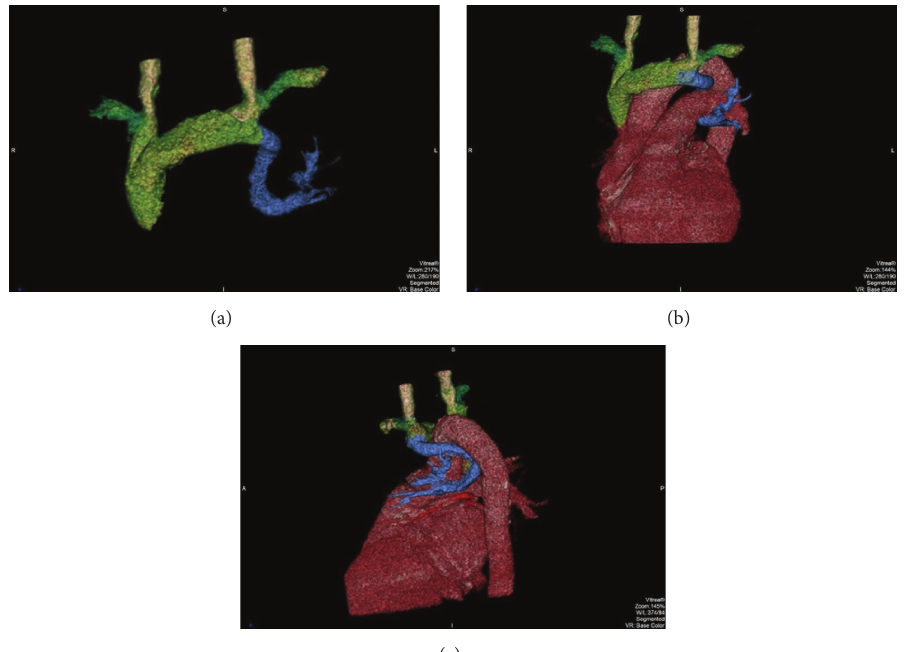
Figure 3: 3D reconstructions: (a, b) the left upper pulmonary vein (light blue) describes a curved line with superior concavity, finally joining the left brachiocephalic vein; (c) the lingular vein (red) has independent drainage to the left